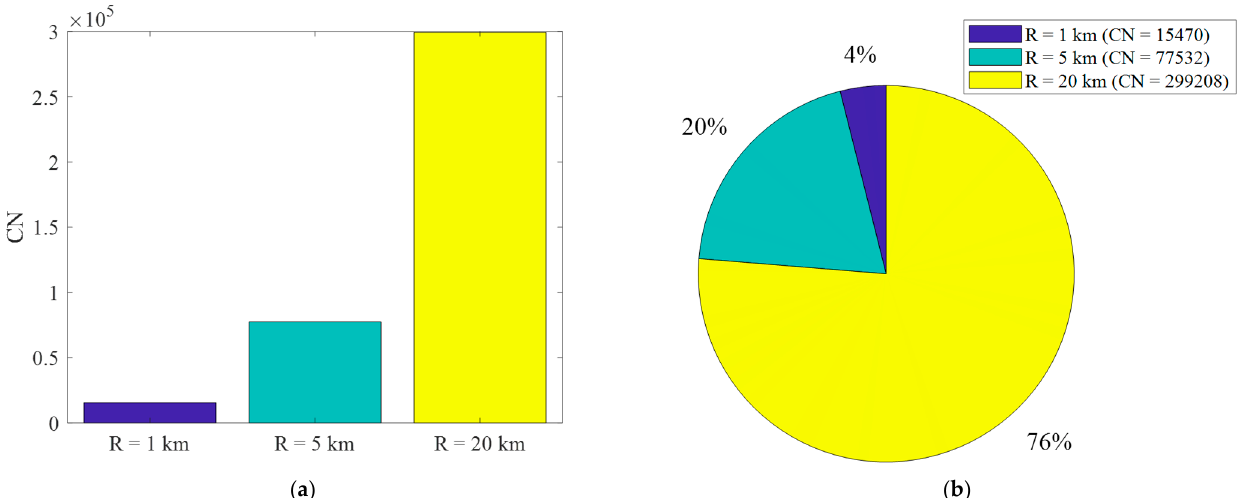
Figure 9. ( a ) Absolute and ( b ) normalized number of all calculations CN for different distances between TX and RX.